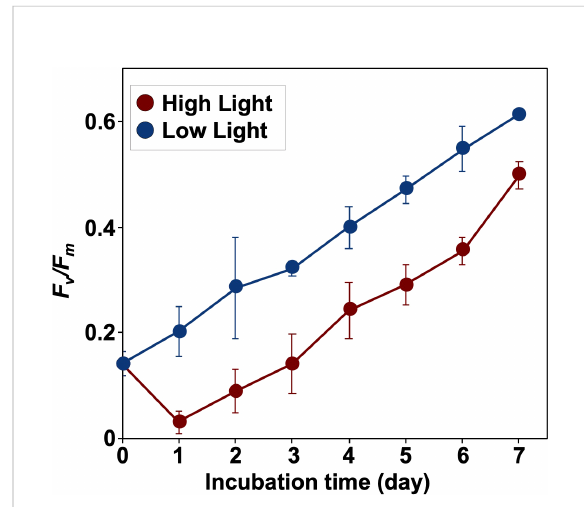
FIGURE 6 Variations in the maximum photochemical ef fi ciency of PSII ( F v / F m ) during incubation. Mean values ( ± SD) indicate the average of three independent